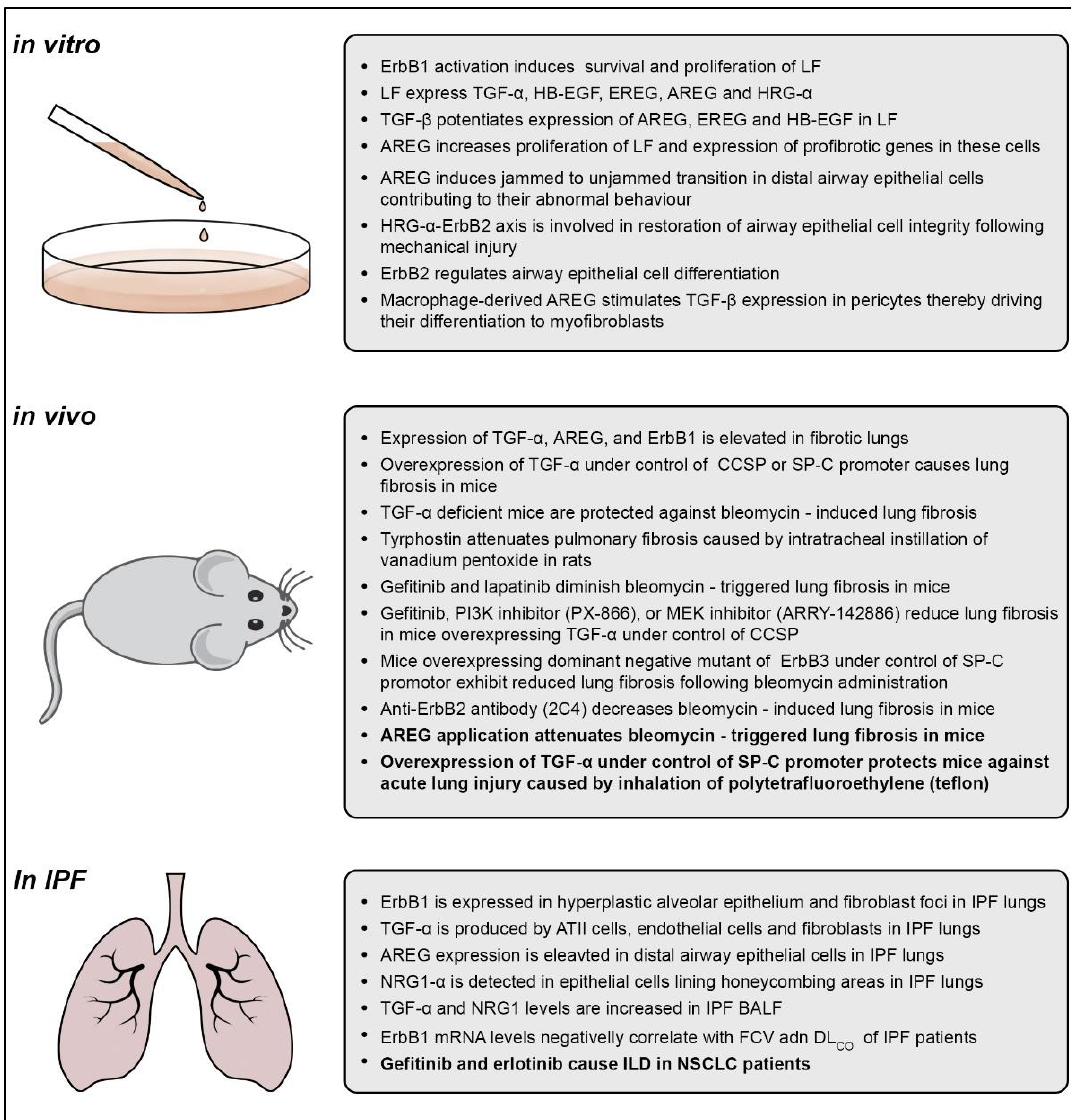
Figure 2. Overview of the in vitro , in vivo and clinical findings for the role of the ErbB/ligand system in lung fibrosis. LF, lung fibroblasts; TGF α , transforming growth factor- α ; HB-EGF, heparin-binding epidermal growth factor-like growth factor; EREG, epiregulin; AREG , amphiregulin; HRG- α , heregulins; TGF- β , transforming growth factor- β ; CCSP, Clara cell secretory protein; SP-C, surfactant protein-C; PI3K, phosphoinositide 3-kinase; MEK, mitogen-activated protein kinase kinase; IPF, idiopathic pulmonary fibrosis; ATII cells, alveolar type II cells; NRG1 α , neuregulin-1 α ; BALF, bronchoalveolar lavage fluid; FVC, forced vital capacity; DL CO , diffusion capacity of the lung for carbon monoxide; ILD, interstitial lung disease; NSCLC , non-small-cell lung cancer. Table 1. Anti-ErbB/ligand approaches in preclinical models of lung fibrosis. Targeted Molecule